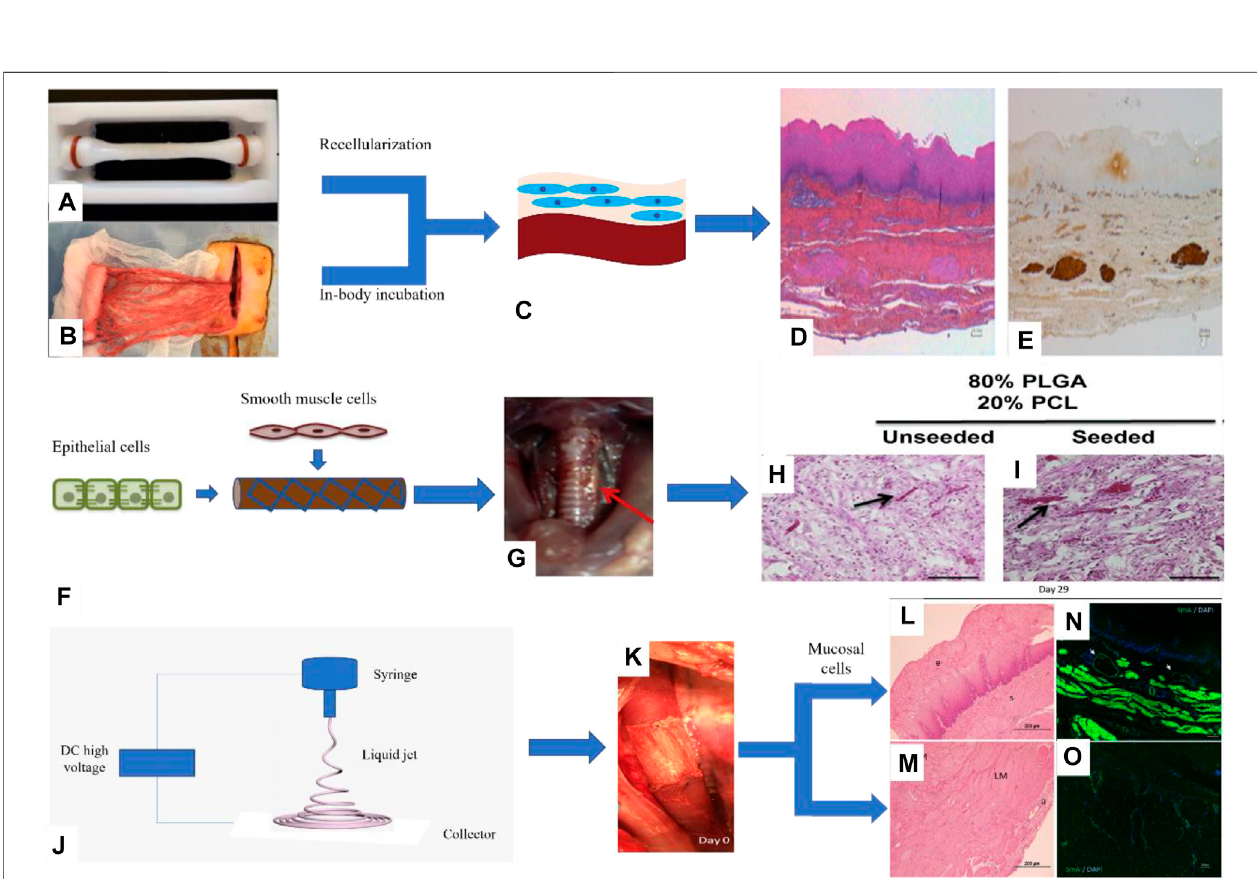
FIGURE 4 | Porcine esophageal acellular matrix and omentum construct a double-layer scaffold to repair esophageal defects. (A) Acellular matrix. (B) Decellularizedmatrixcompositeomentum. (C) Omentummaturationinpigs. (D) H&Estainingofpigesophagussections. (E) Immunohistochemicalstainingtodetectthe expression of desmin in porcine esophagus tissue (Levenson et al., 2021). II. The PLGA/PCL electrospinning scaffold was prepared by the one-step method combined with ECs and myocytes to repair esophageal defects: (F) Cells were cultured on the inner and outer surfaces of the scaffold. (G) The scaffold is a patch to